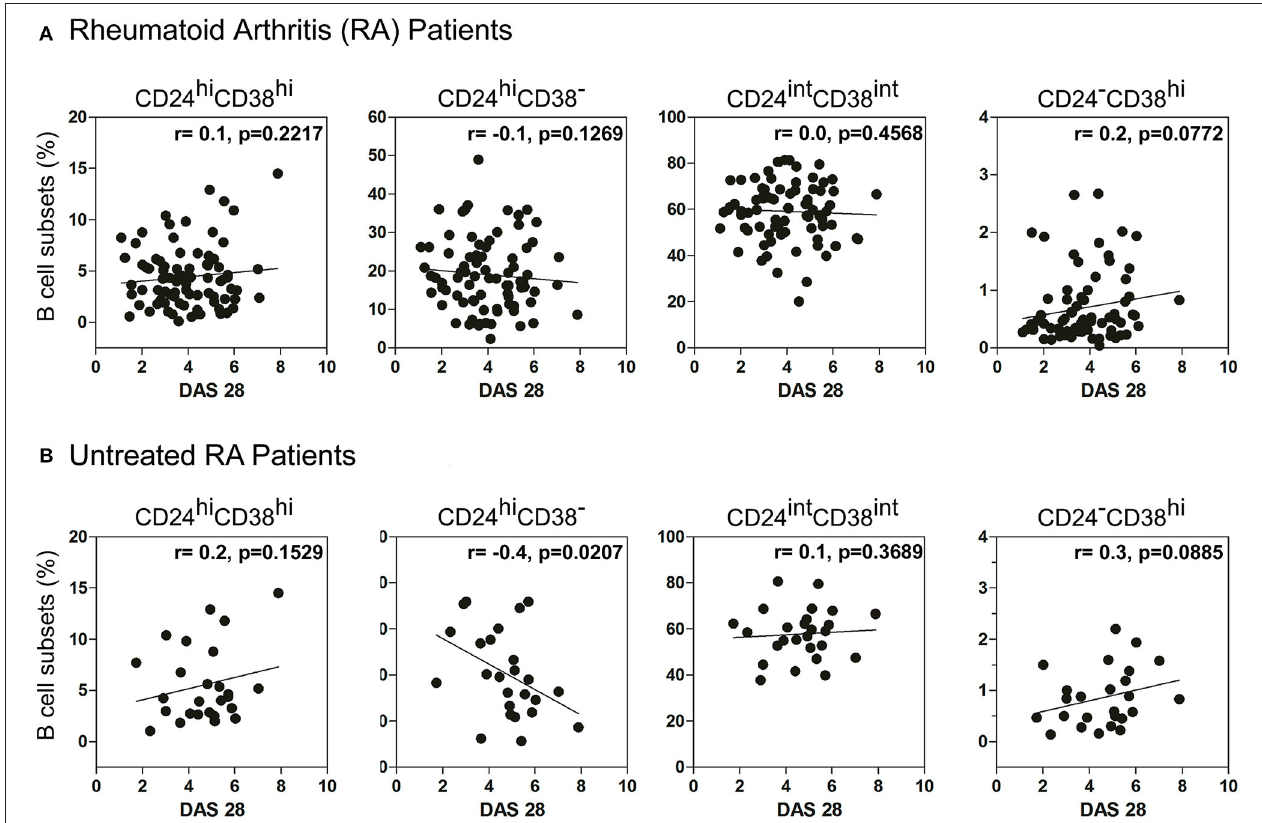
FIGURE 2 | Correlation between DAS28 and the frequency of B cell subsets. Correlation plots show the relationship between DAS28 and the frequencies of immature (CD24 hi CD38 hi ), memory (CD24 hi CD38 − ), mature (CD24 int CD38 int ) and plasmablast (CD24 − CD38 hi ) CD19 + B cells in (A) treated and untreated RA patients ( n = 80) and (B) untreated RA patients ( n = 26). Correlation analysis was performed with Pearson’s correlation test and a p value < 0.05 was considered statistically